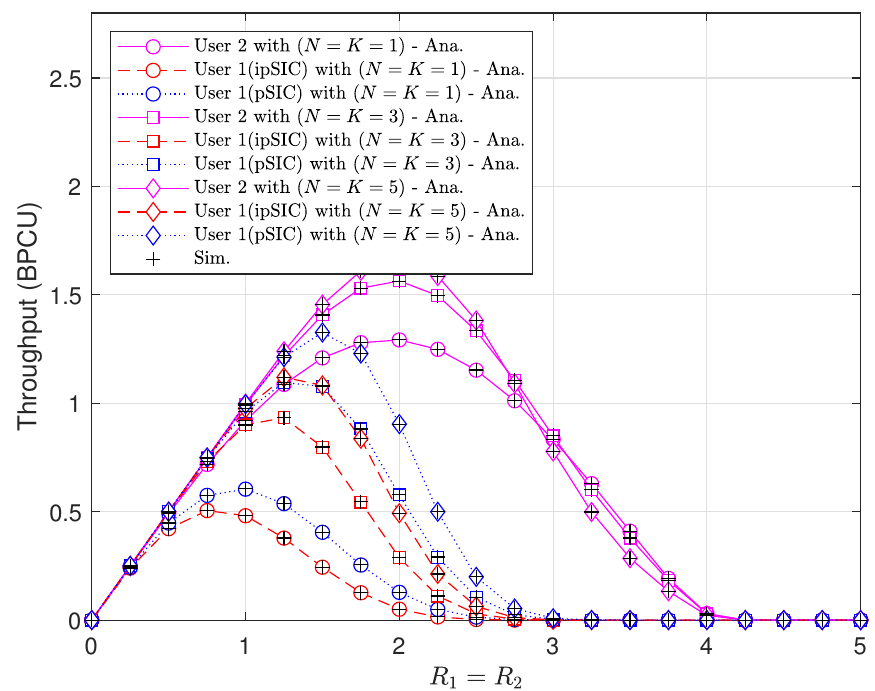
Figure 8. Throughput performance versus target data rates with a 1 = 0.95, a 2 = 0.05, m = 2, and ρ = 5